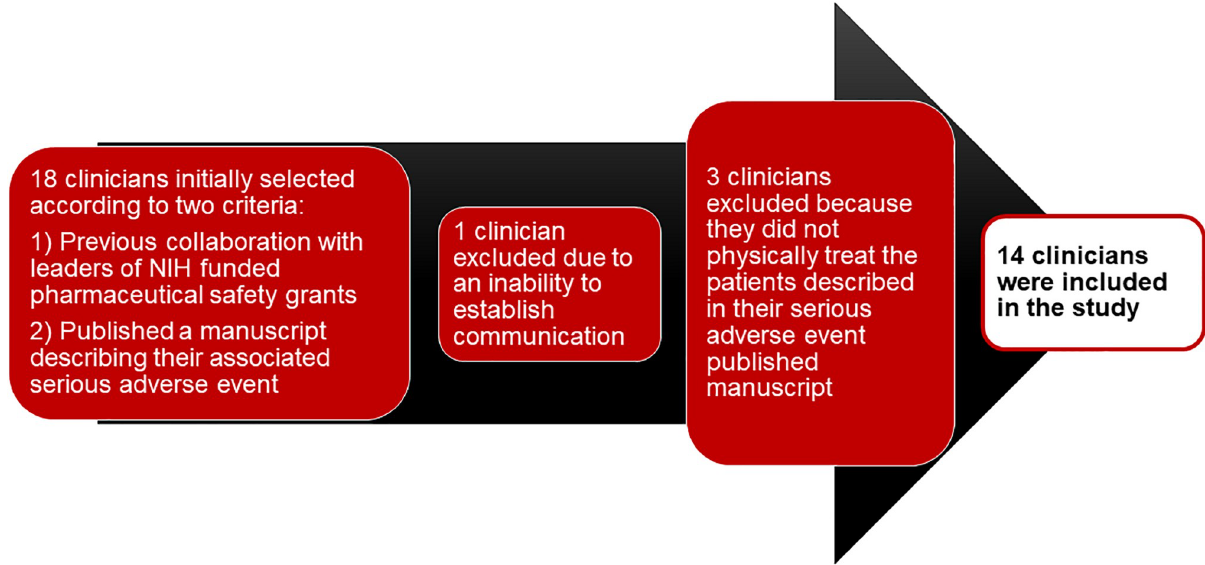
Fig 1. Flow chart for study inclusion